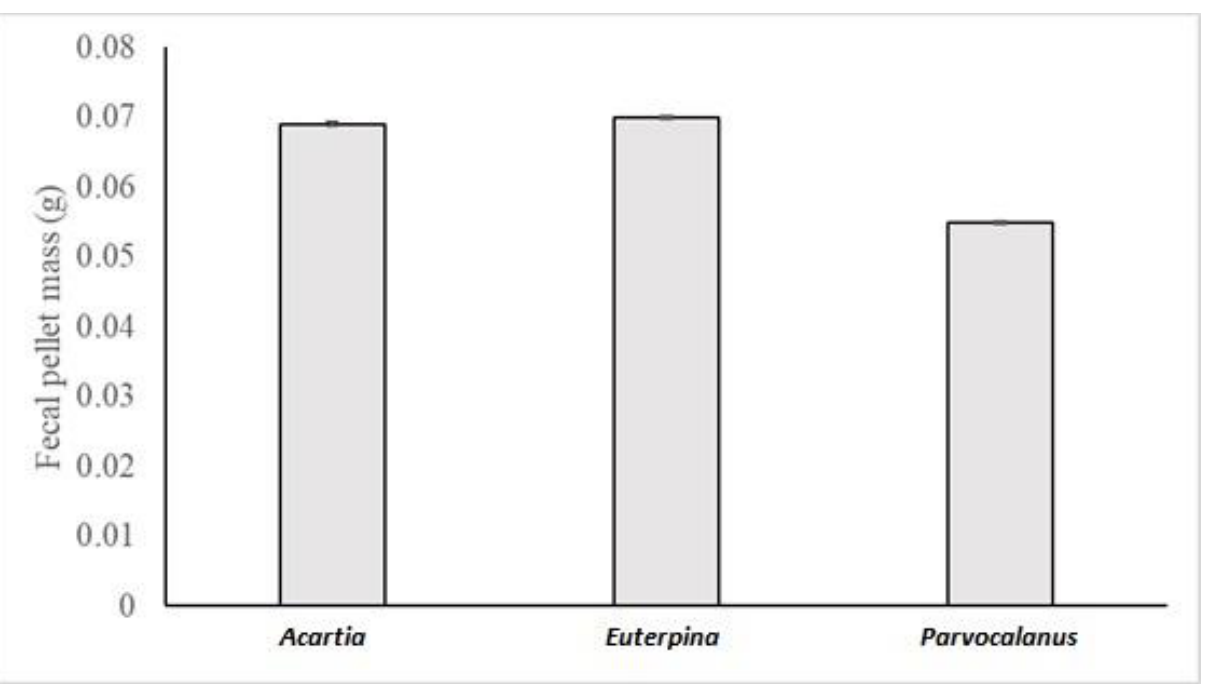
Figure 3. Fecal pellet mass (in g) for the 3 copepod species ( Acartia pacifica , Euterpina acutifrons and Parvocalanus crassirostis ). Results are presented as mean ± SEM.